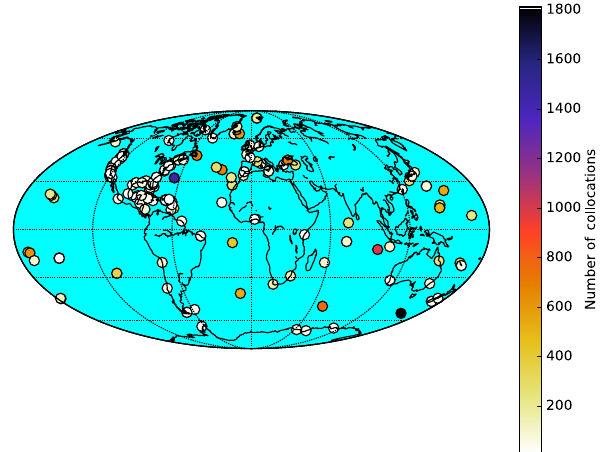
Figure 4. Overview of location and data density of GNSS stations used for TCWV